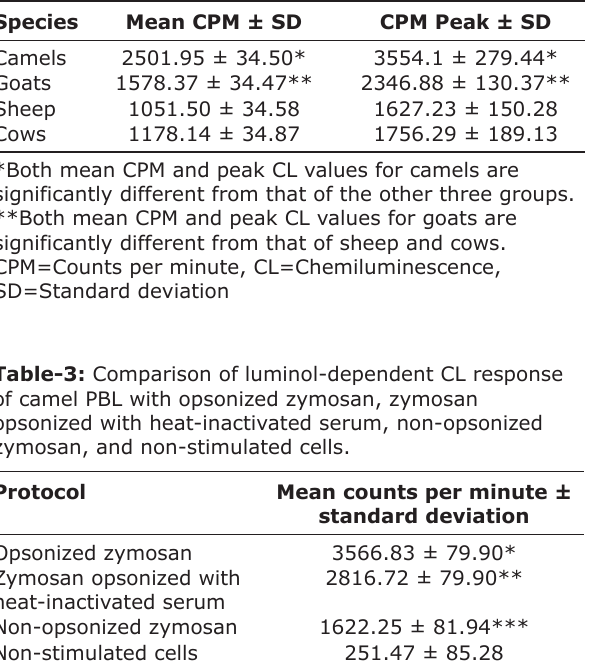
Table-2: Comparison of the isoluminol-dependent mean CPM and peak CL values of camels, goats, sheep, and cows.